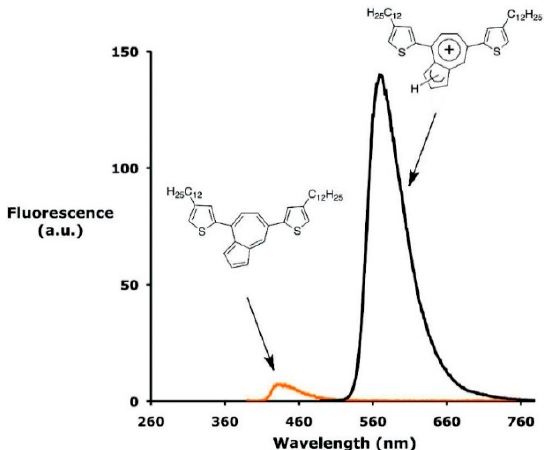
Figure 5. Fluorescence measurements in dichloromethane for neutral oligomer 7 and after protonation to give 7H + . Reprinted with permission from [41], Copyright 2011, American Chemical Society.